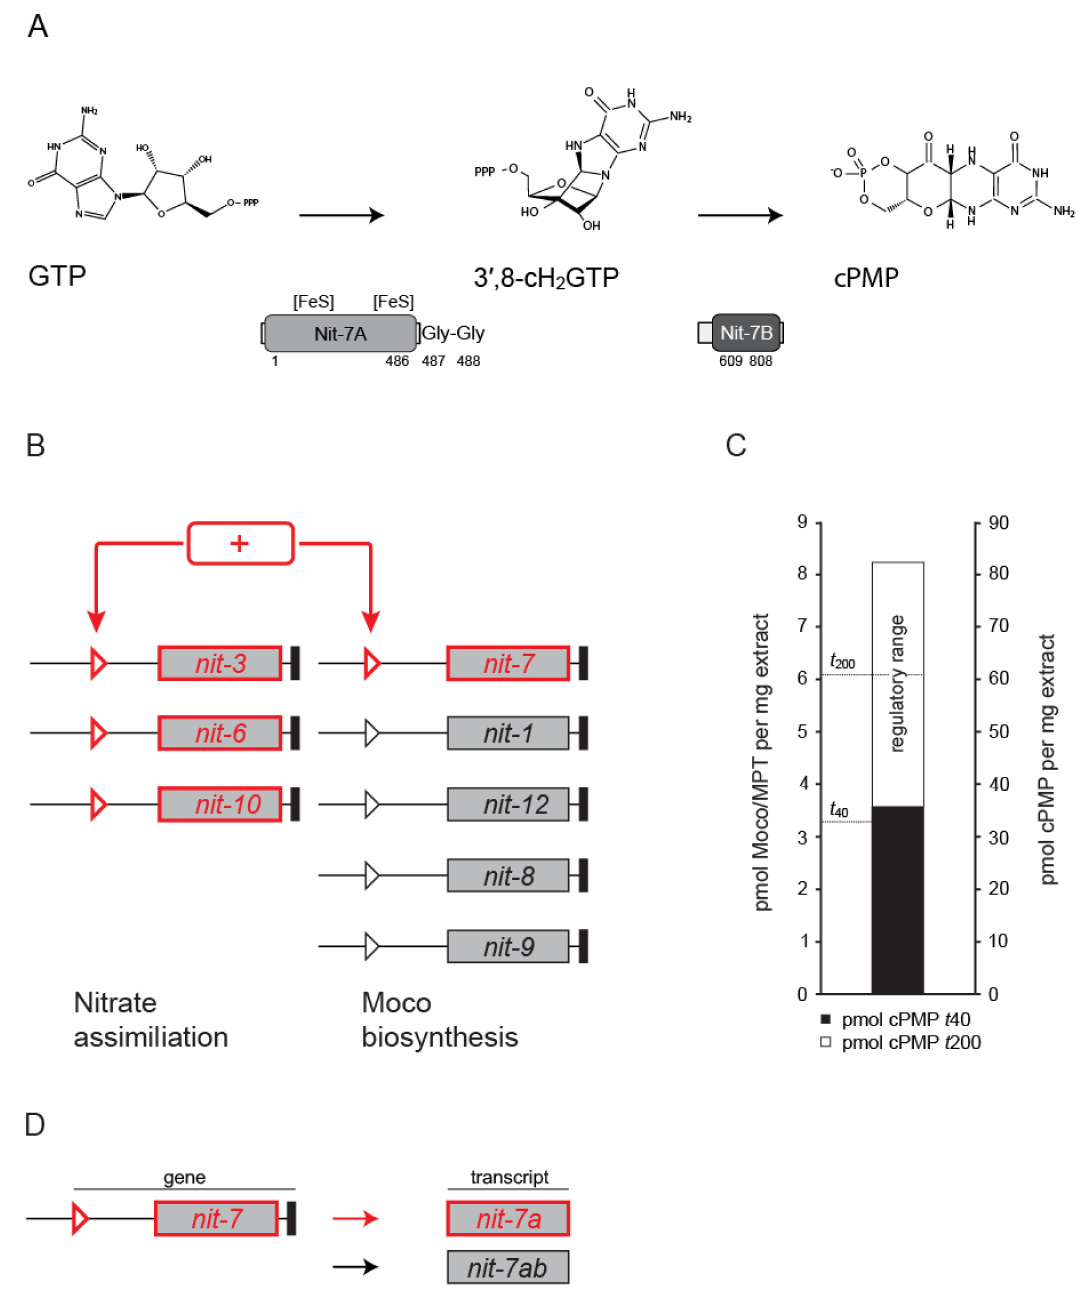
Figure 8. Co-regulation of Neurospora crassa molybdenum cofactor biosynthesis and nitrate assimilation. ( A ) Schematic reaction detail of the first step of molybdenum cofactor (Moco) biosynthesis, where GTP is sequentially processed yielding 3´,8-cH 2 GTP as intermediate and cyclic pyranopterin monophosphate (cPMP) as reaction product. Here, NIT-7A is suggested to act as 3´,8-cH 2 GTP cyclase, whereby NIT-7B is assumed to function as cPMP synthase [8,9]. ( B ) Schematic representation of the interlaced regulation of the Moco biosynthesis and nitrate assimilation pathway in Neurospora crassa . + = nitrogen derepressing (N-derepressing) and nitrate-inducing conditions. Triangles indicate the promotors, black boxes the terminators of the genes indicated. ( C ) Quantitative data for cellular Moco / molybdopterin (MPT) and cPMP amounts at t 40 and t 200 (single biological experiment, see Figure 2). The dashed lines indicate the Moco / MPT synthesis implemented at t 40 and t 200 , respectively. The regulatory range is defined as t 200 – t 40 . ( D ) Detail of the regulatory scheme shown in (B). Under N-derepressing and nitrate-inducing conditions (red arrow), the non-splice nit-7 transcript (encoding NIT-7A, see A) is increasingly